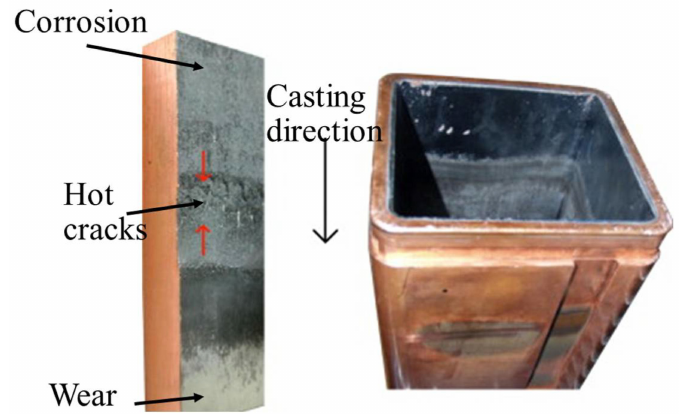
Figure 8. ( left ) Schematic representation of edge wear, hot star crack, narrow surface shrinkage, and high temperature oxidation of copper lining of the mould, and ( right ) Image of mould after use with degraded inner lining. The cross section of rectangular tube moulds typically range from 0.6 m 2 to 2.5 m 2 . Adapted with permission from [39]. 2014, Elsevier.